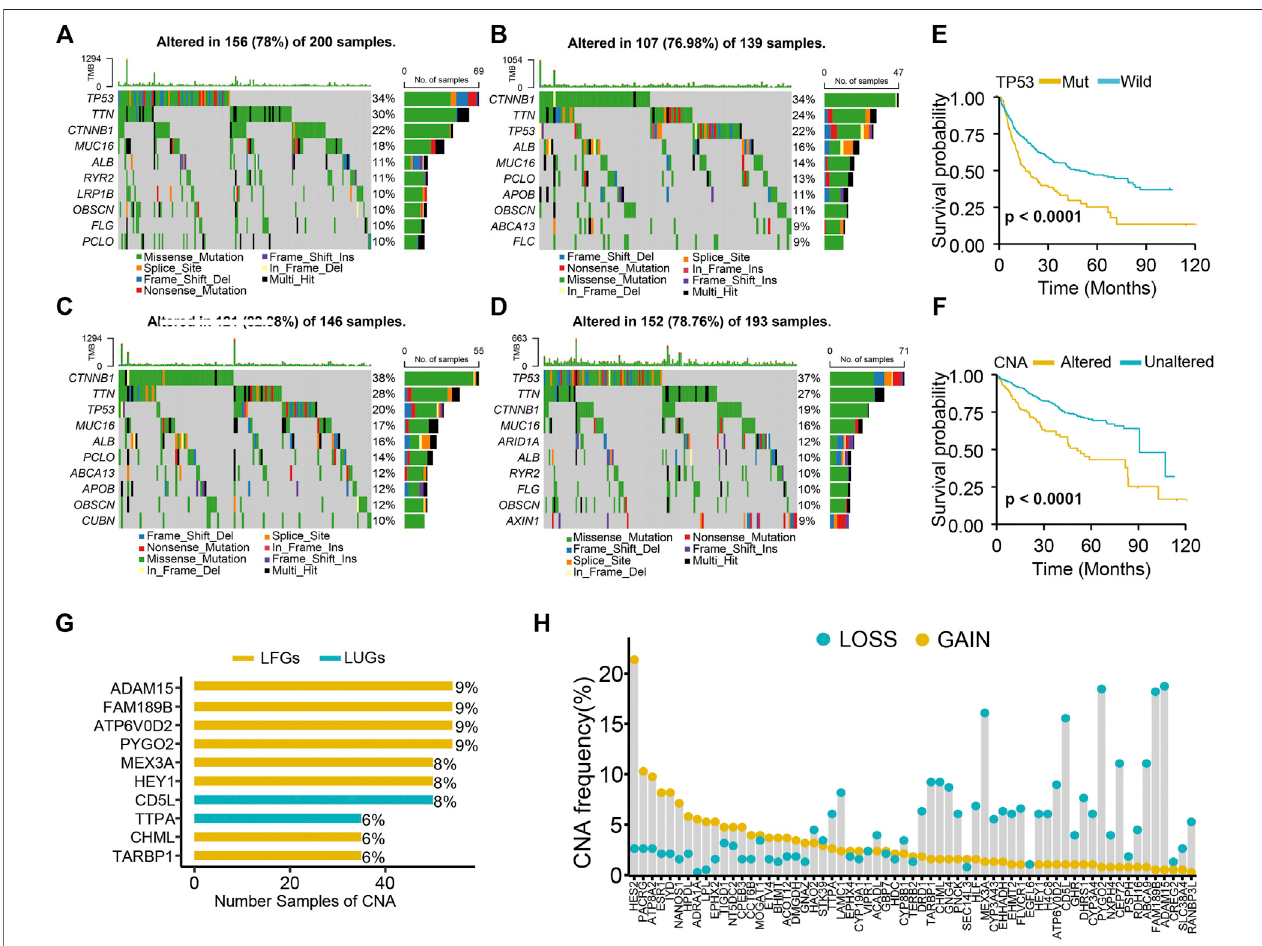
FIGURE 6 | Genetic alteration analysis. (A) Mutation landscape of high-LUGs score group, (B) low-LUGs score group, (C) high-LFGs score group, and (D) low- LFGsscoregroup. (E) KMcurveofTP53mutation. (F) KMcurveofCNA. (G) Thetop10LCGswiththehighestfrequencyofCNV. (H) FrequenciesofCNVgain,loss,and non-CNV among